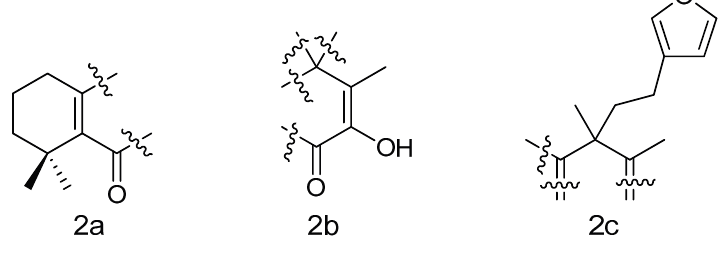
Figure 2. Partial structure of compound 1